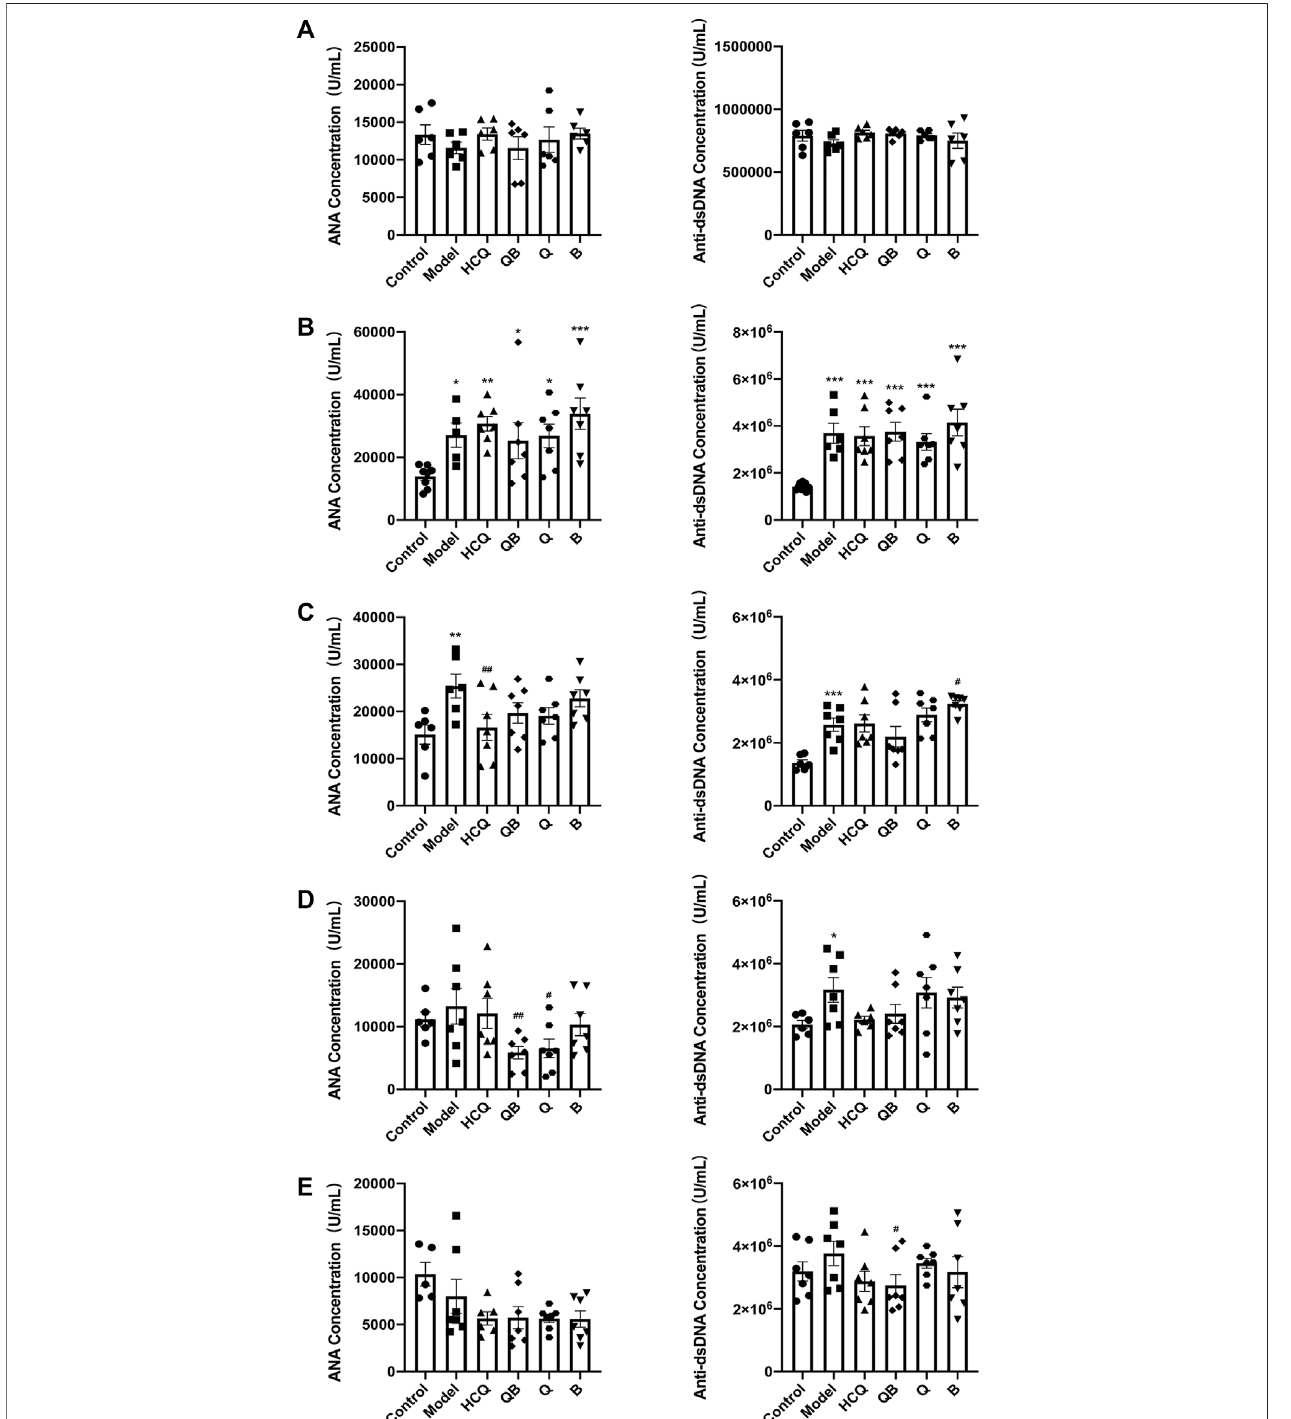
FIGURE2| Qinghao-Biejiacanreduceautoantibodyproduction. (A) Theantinuclearantibodies(ANA)andanti-double-strandedDNAantibodies(anti-dsDNA)level priortomodeling. (B) TheANAand anti-dsDNA levelafter modeling(compared withthecontrolgroup, * p < 0.05,** p < 0.01,*** p < 0.001). (C) TheANA andanti-dsDNA level after 4 weeks of dosing. (D) The ANA and anti-dsDNA level after 8 weeks of dosing. (E) The ANA and anti-dsDNA level after 12 weeks of dosing. The data are expressed asthemean ±SEM.Modelgroup compared withthecontrolgroup, * p < 0.05, ** p < 0.01,*** p < 0.001;the remaininggroups compared withthemodel group, # p < 0.05, ## p <